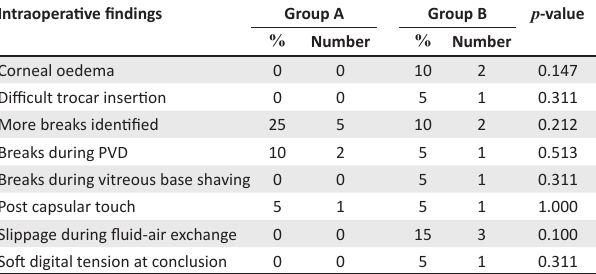
TABLE 2: First procedure intraoperative